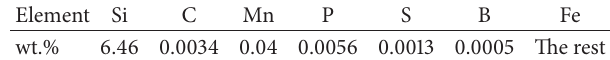
Table 1: Chemical composition of Fe-6.5wt.%Si alloy. Element Si C Mn P S B Fe wt.%